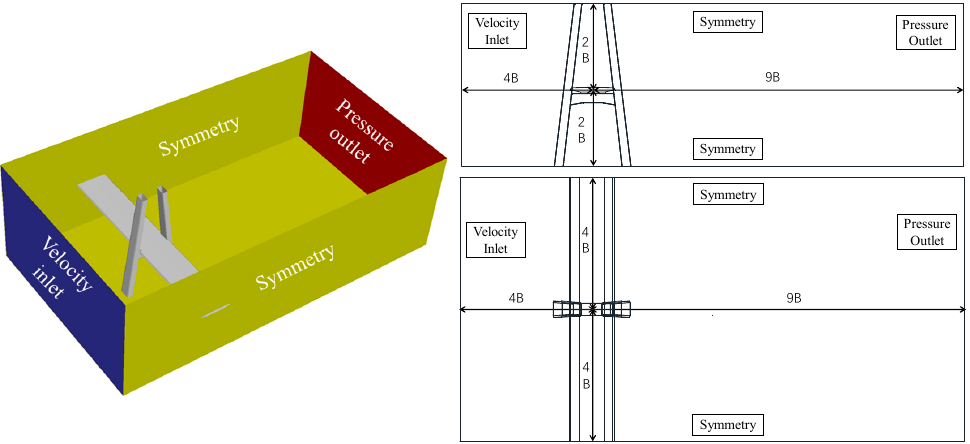
Figure 4. Boundary conditions of computational domain (B is the girder width 41 m).